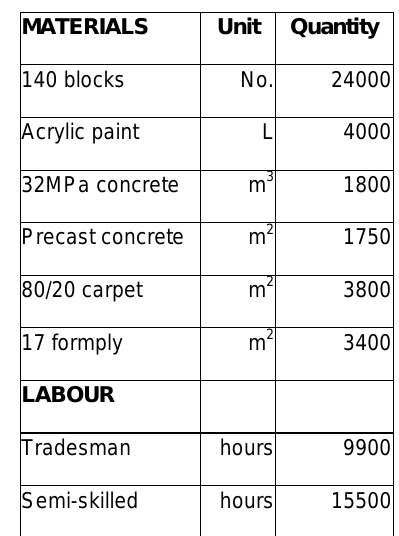
Table 4: Mini basket of goods (BLOC) - rounded